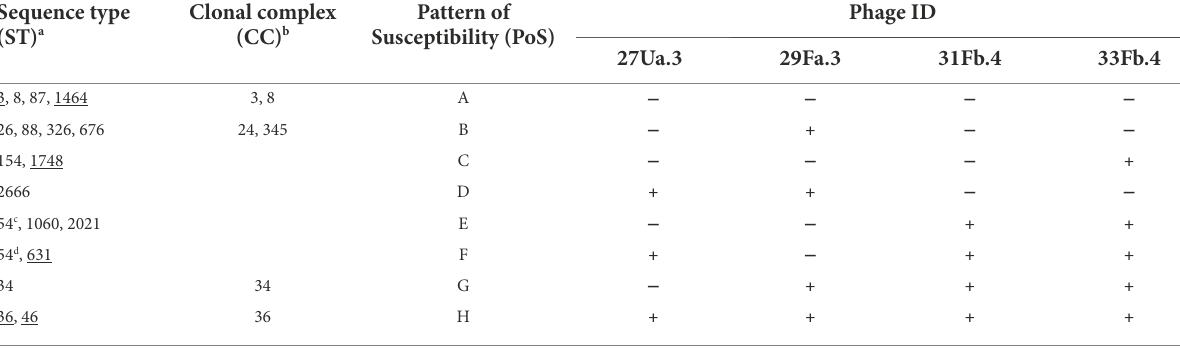
TABLE 3 Patterns of susceptibility of Vibrio parahaemolyticus ST and CC to phages. Sequence type (ST) a